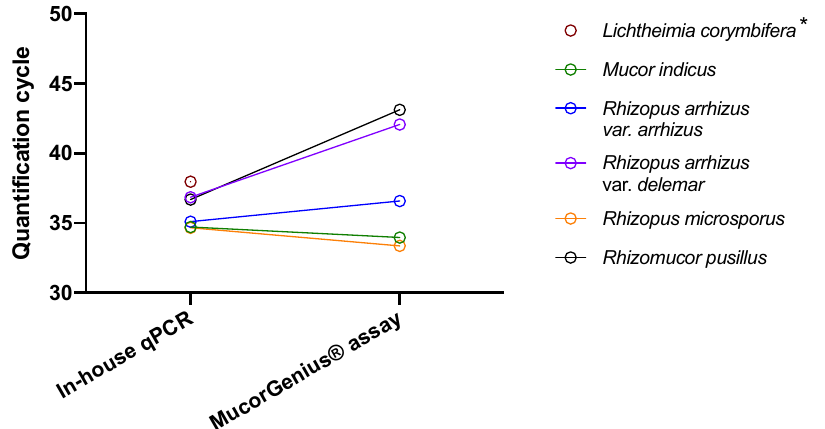
Figure 2. Comparison of qPCR assays based on spiked serum specimens detectable with both assays. The six sera spiked with DNA from fungi targeted by the two qPCR ( Lichtheimia corymbifera , Mucor indicus , Rhizopus arrhizus var. arrhizus , Rhizopus arrhizus var. delemar , Rhizopus microsporus and Rhizomucor pusillus ). * Lichtheimia corymbifera was not amplified with the MucorGenius® assay.